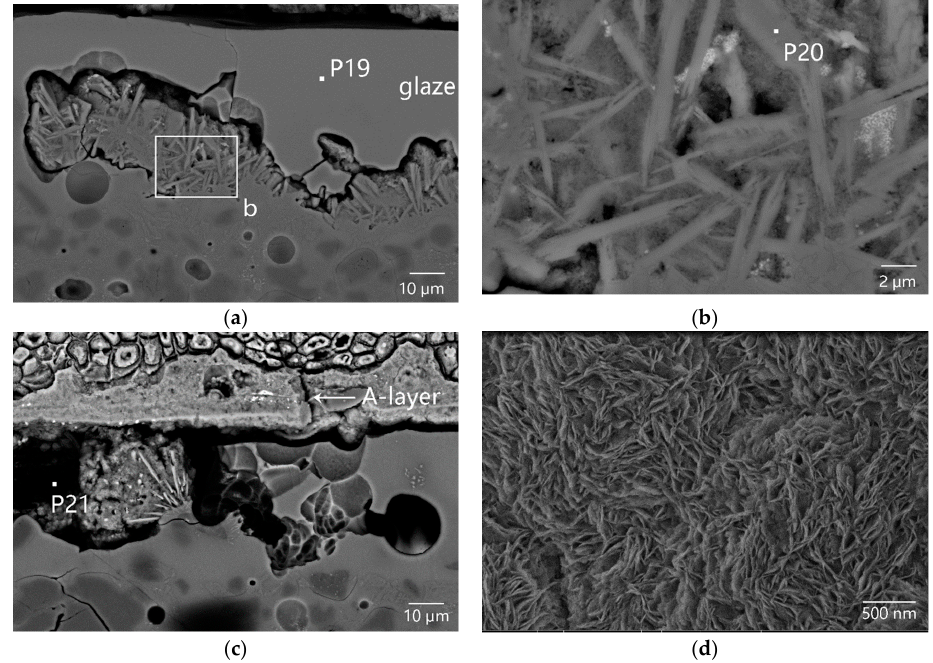
Figure 11. Cross-sectional SEM image of the coagula/glaze interface in sample DL-1: ( a ) at the bottom of No. 2 box in Figure 8a, in which the residual glaze and the body/glaze interlayer were observed, ( b ) rod-like anorthite crystals in the body/glaze interlayer, ( c ) No. 3 box of Figure 8a, in which the broken glaze between the cellular coagula and the body were observed, and ( d ) morphology of the foreign pollutants deposited in the pore at P21.